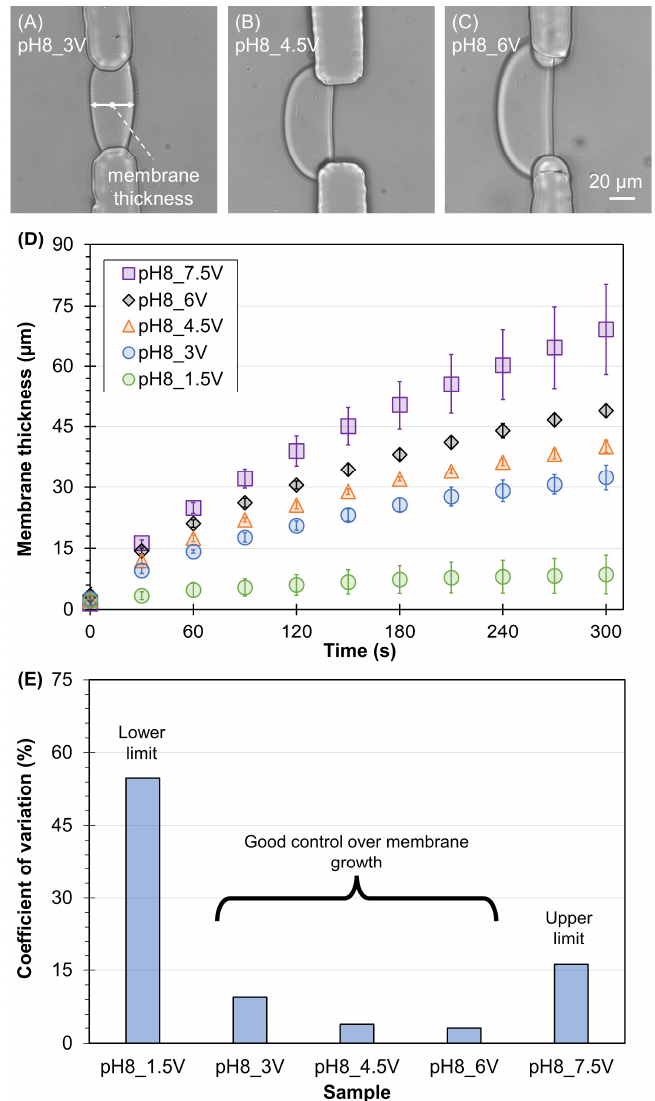
Figure 2. Determining the boundaries of applied voltage for the electrofabrication of freestanding chitosan membranes in microfluidics. ( A – C ) Representative chitosan membrane electrofabricated in 5 min using the voltage of 3, 4.5, and 6 V, respectively. ( D ) Typical membrane growth curves of chitosan membranes electrofabricated with different voltages (1.5, 3, 4.5, 6, and 7.5 V) while the pH of alginate solution was fixed at 8. ( E ) The percentages of the coefficient of variation of membranes electrofabricated under varied voltage for 5 min.